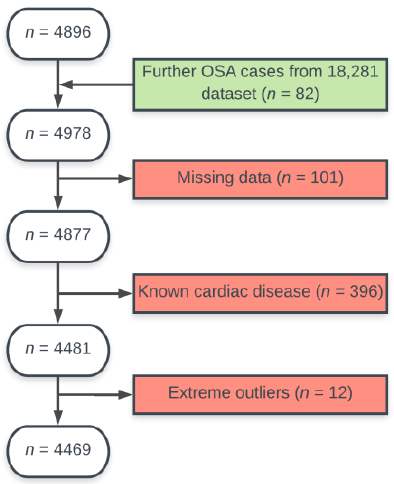
Figure 1. Case selection flow chart .